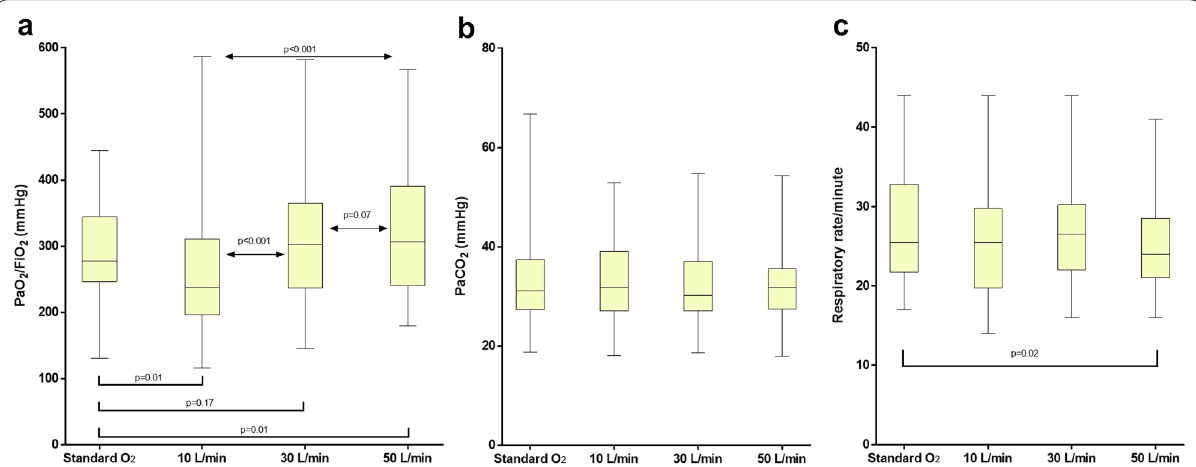
Fig. 1 PaO 2 /FiO 2 ( a ), PaCO 2 ( b ) and respiratory rate ( c ) in the four study steps. Results are displayed as median, interquartile range, maximum and minimum. With HFOT TRACHEAL device, PaO 2 /FiO 2 increases proportionally to gas flow, especially between 10 and 30 L/min. As compared to standard oxygen, 50 L/min, but not 30 L/min nor 10 L/min, ameliorate oxygenation and reduce respiratory rate in isocapnic